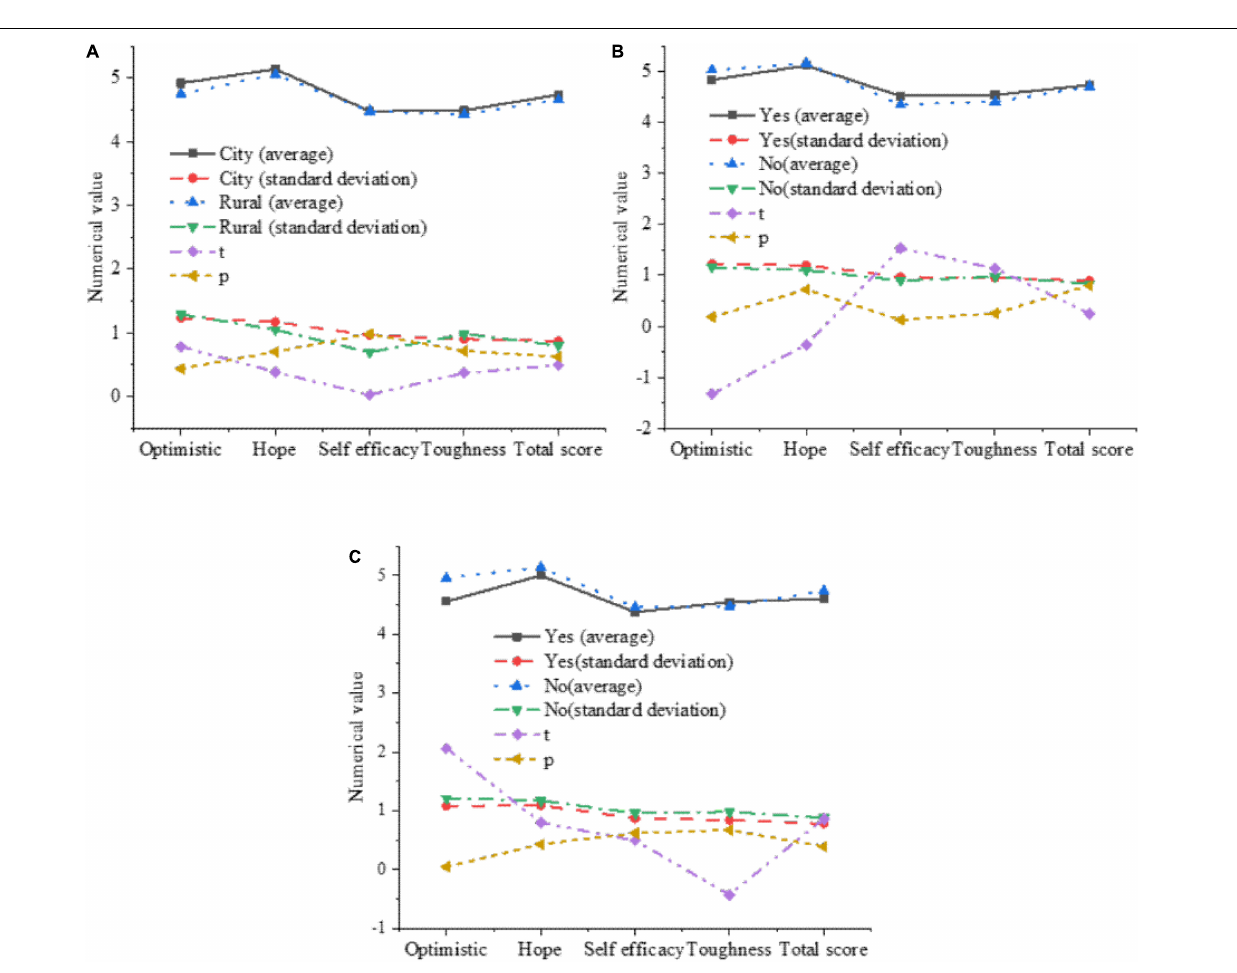
FIGURE 8 | The influence of various factors on the psychological quality of college students. (A) The impact of the birthplace on the psychological quality of college students. (B) The impact of whether it is an only child on the psychological quality of college students. (C) The impact of single-parent families on the psychological quality of college